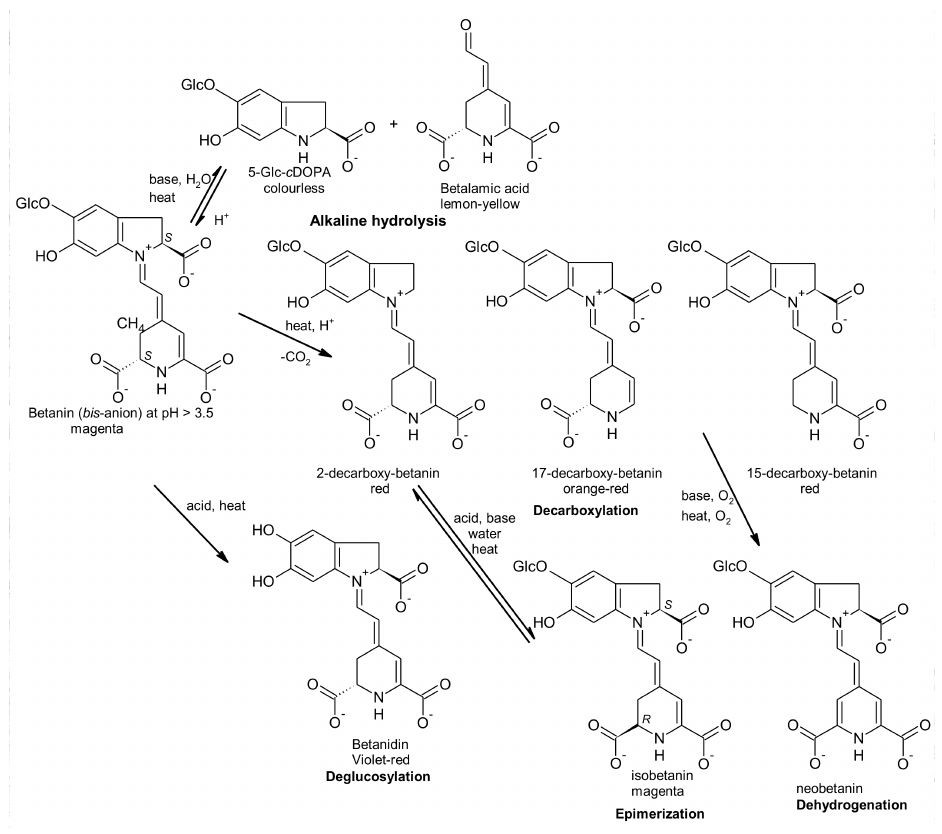
Figure 3. Betanin degradation products and some degradation pathways (adapted from